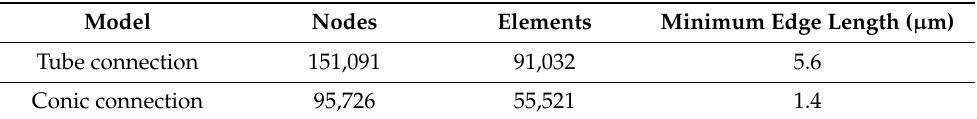
Table 2. Nodes and